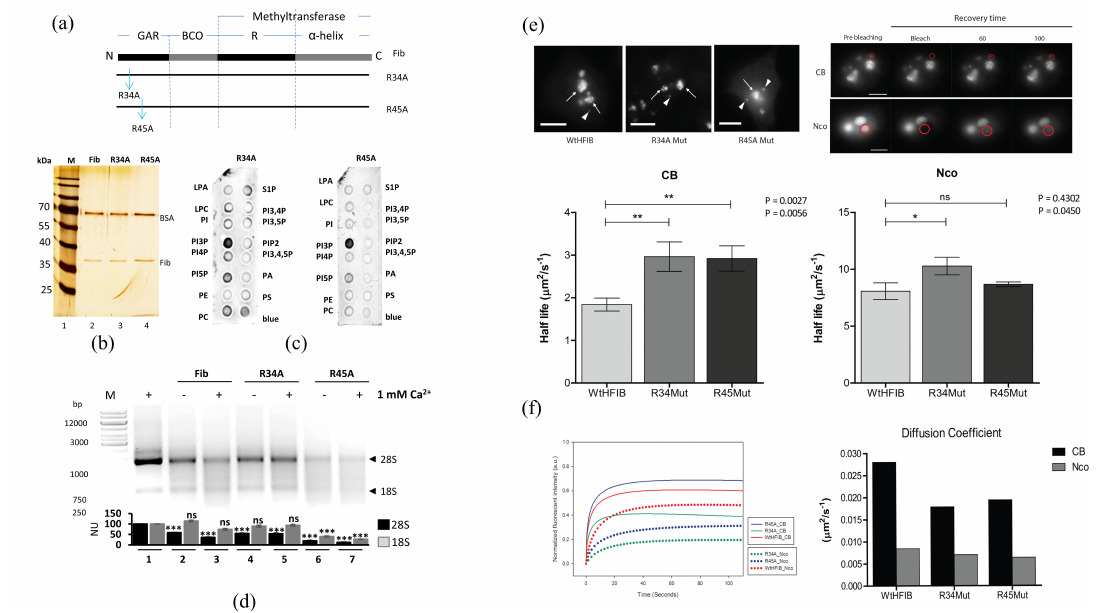
Figure 5. Activity of GAR domain mutants. ( a ) Schematic representation of fibrillarin domains GAR, BCO, and RNA binding alpha-helix domain. Blue arrows represent mutations R34A and R45A in the fibrillarin GAR domain. ( b ) Silver stain normalization of WT, R34A, and R45A fibrillarin. ( c ) Fat blot assay for fibrillarin mutants R34A and R45A. Figure S1 depicts the quantification signals made by ImageJ software. ( d ) RNA activity of fibrillarin mutants R34A and R45A. Quantification of 28S and 18S signals were made by ImageJ software and statistical significance was determined by t -test (* p -value < 0.05; ** p -value < 0.01; *** p -value < 0.001, ns = not significant p -value > 0.05) and plots are indicated below the gels from n = 3. ( e ) Transiently transfected HeLa cells expressing GFP-WT-fibrillarin, R34A, or R45A mutant coupled to GFP. In the upper left panel, representative images of the conventional localization of human fibrillarin in nucleoli (arrows) and Cajal bodies (arrowheads) are shown for WT and mutants. Intranuclear localization for WT fibrillarin and its mutants was observed in live cells. On the upper right panel, one representative photobleaching experiment is shown for a Cajal body and, for a nucleolus, red circles delimit the ROI, which was subsequently photobleached. The lower graphs plot the half-life coe ffi cients obtained from 200 independent FRAP experiments comparing WT and mutants fibrillarins in CBs and NCOs; error bars correspond to SEM. ( f ) The left graph represents the normalized dynamics from 200 independent photobleaching events for WT and mutant fibrillarins in CBs and NCOs; the curves in the graphs represent the normalized values of the mean ( n = 200) for each condition for each time point. The bar graph on the left shows a resume of the single di ff usion coe ffi cient values obtained from the previous